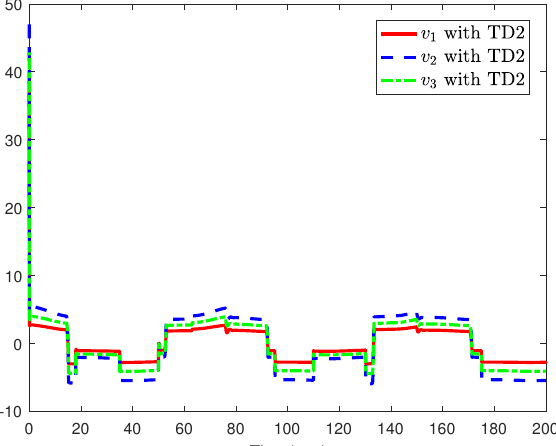
Figure 5. Control effect of System (3) under